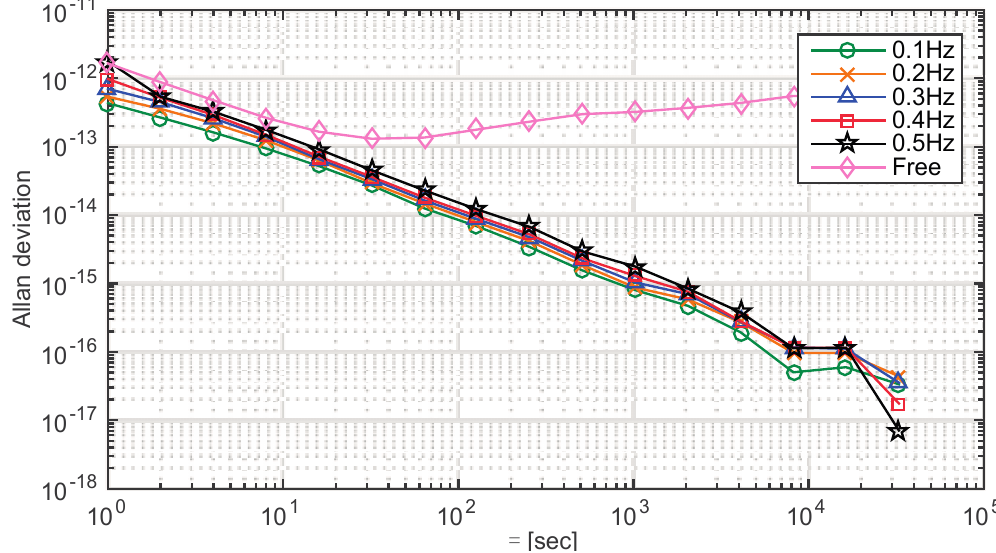
Figure 12. Comparison of the Allan deviations of a free run slave clock and a controlled clock for different control bandwidths. Data from the 1st hour to the 24th h are truncated to evaluate the synchronization performance. The standard deviations of the stable loops and the free run clock are 2.4 picosecond, 2.7 picosecond, 2.9 picosecond, 3.2